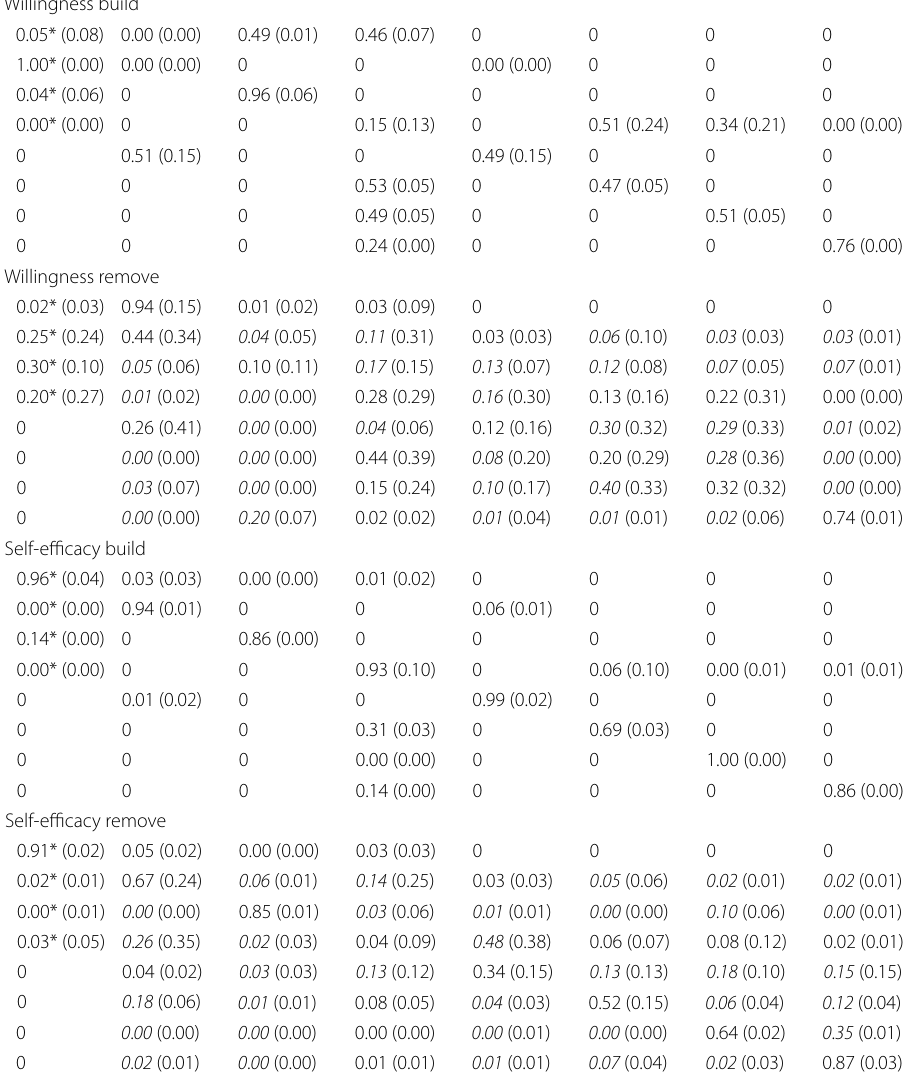
Estimated weights and standard deviations for willingness and self‑efficacy across 10 runs for network 3 using network built with connections known to exist and network where connections known not to exist are removed where weights placed on leaders is indicated with * and italic estimated weights in the remove matrix which are fixed in the build